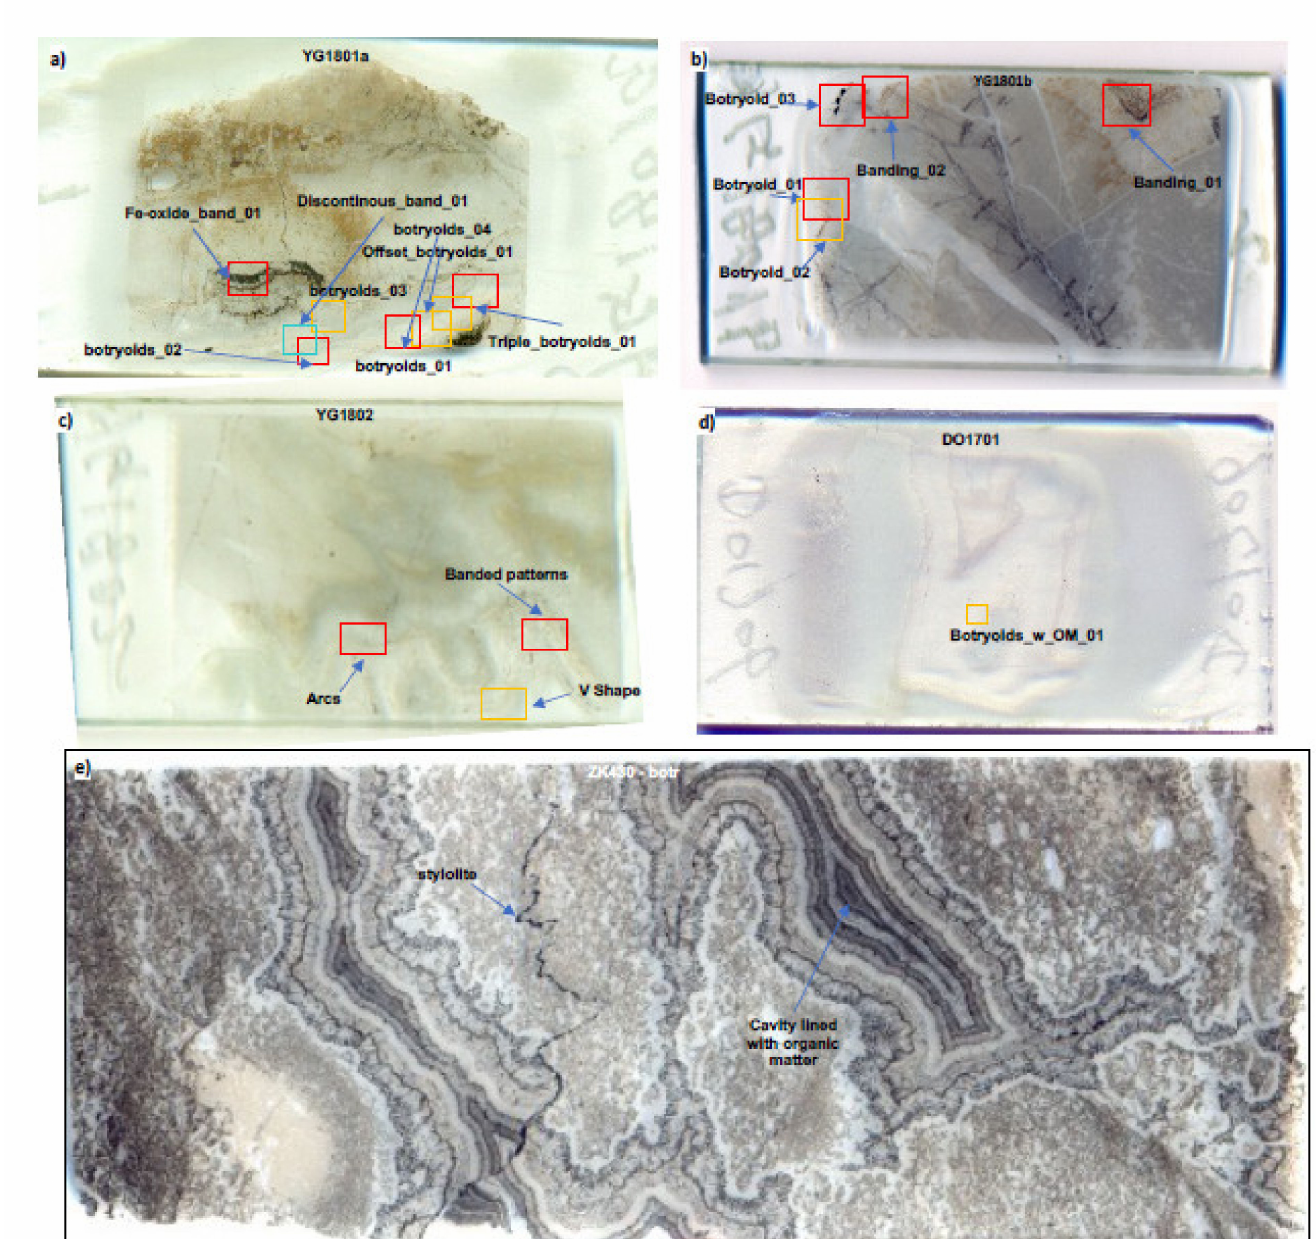
Figure 5. Transmitted light images of the thin sections of the studied rock samples. ( a ) and ( b ) Thin sections of two sub-samples of the heterogeneous Doushantuo quartz botryoids (YG1801). ( c ) Quartz botryoids from another cavity from the Doushantuo member I (YG1802). ( d ) botryoidal quartz from ‘sheeted cracks’ (DO1701). ( e ) Botryoidal dolomite from the Dengying Formation (ZK430-botr). All thin sections are 2.5 cm wide (vertical direction). Botryoid targets analysed in this work are shown in red outlines (polarising microscopy) and orange outlines